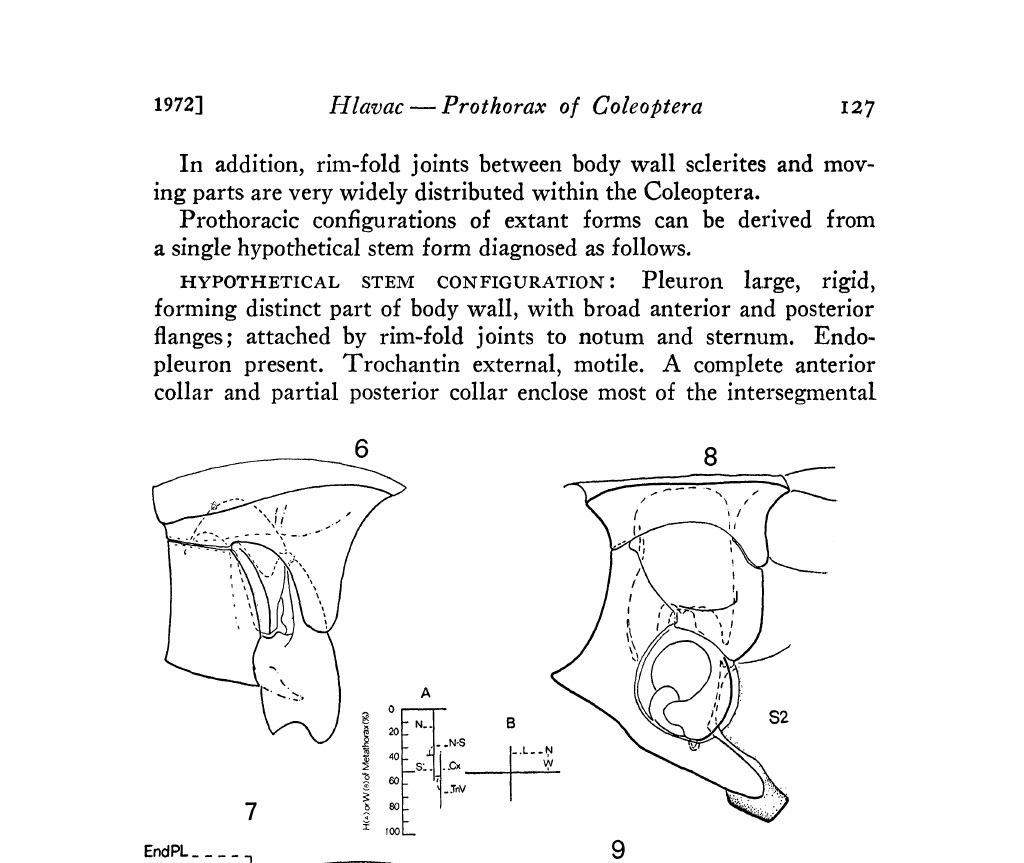
Figs. 6-9. Prothoraces ot Polyphaga and Adephaga. Figs. 6, 7. Lateral external and internal views of Omalium marginatum (Polyphaga, Staphylinidae). [See text and captions ot Figs. 25-55 for ex- planation of Fig. 6A, B]. Figs. 8, 9. Same of Ylmthizoa insolens (Adephaga,